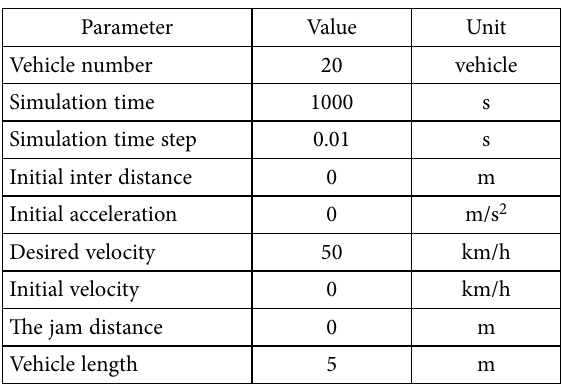
Table 4. Simulation parameters